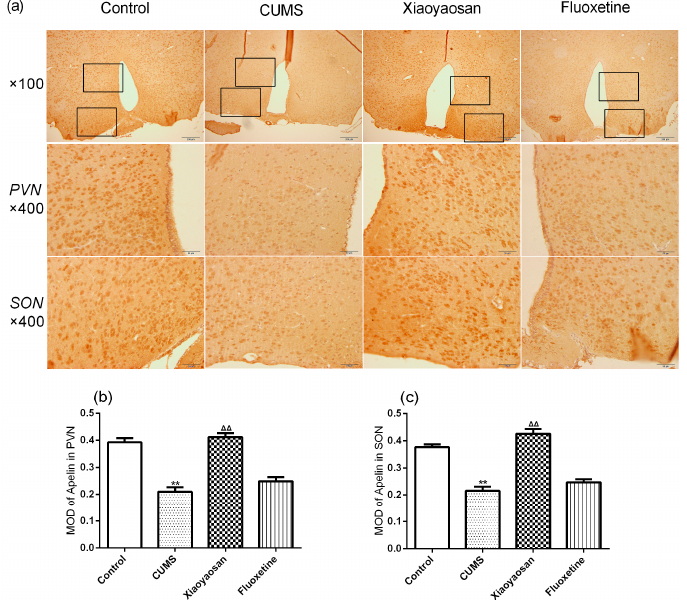
Figure 6. ( a ) Representative micrographs of immunohistochemical staining for apelin (scale bar = 50 μm, 400× magnification) in the PVN and SON; ( b ) The result of image analysis of apelin in PVN; ( c ) The result of image analysis of apelin in SON. MOD, mean optical density. Data were expressed as means ± SEM ( n = 5), ** p < 0.01 versus control group; ΔΔ p < 0.01 versus CUMS group.